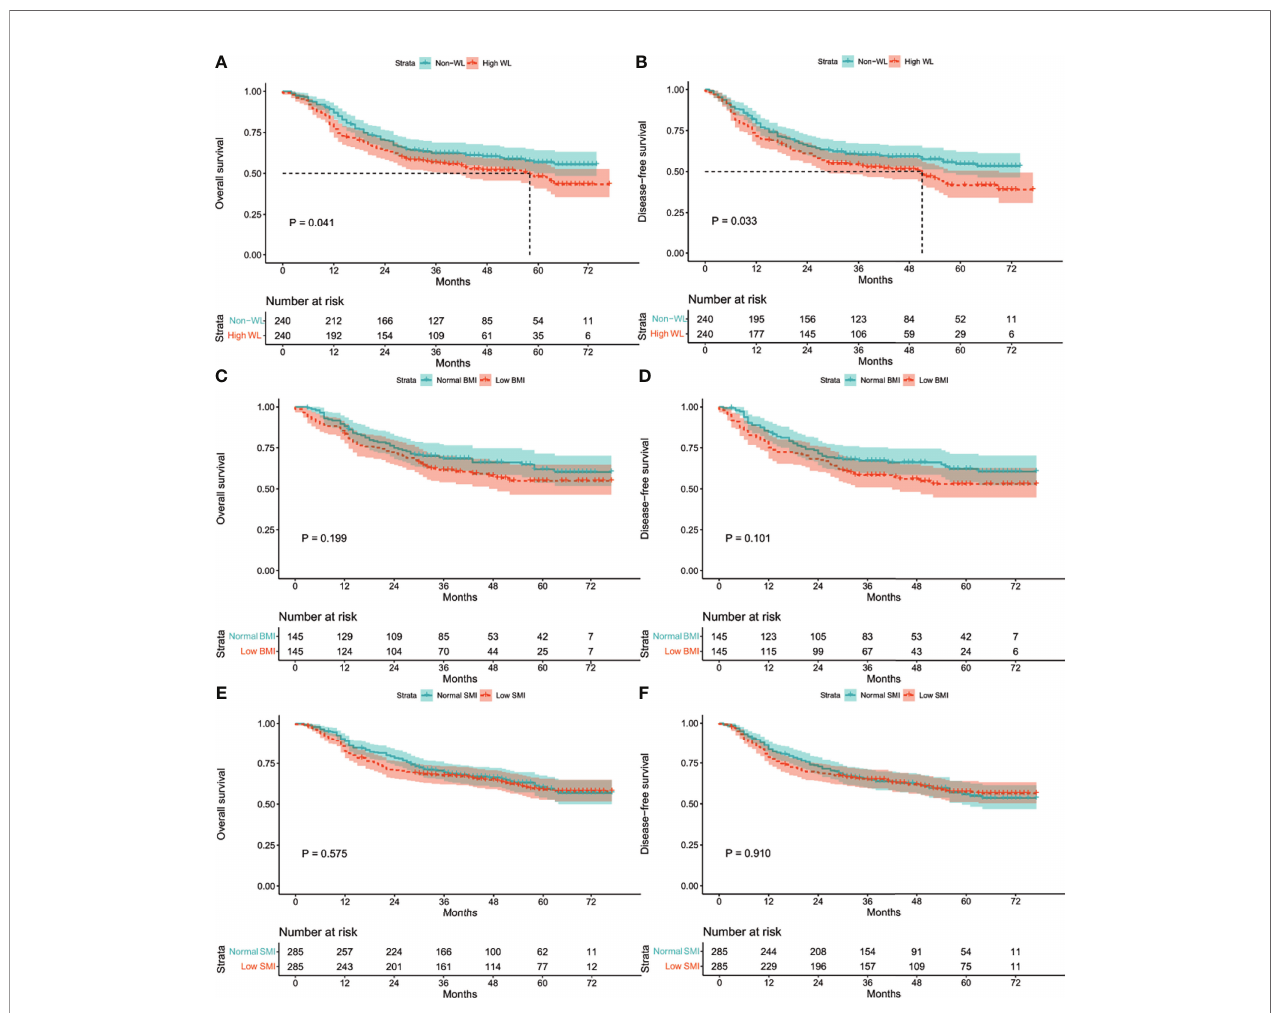
FIGURE 2 | Kaplan-Meier curves: (A) in the matched WL cohort for OS rate; (B) in the matched WL cohort for DFS rate; (C) in the matched BMI cohort for OS rate; (D) in the matched BMI cohort for DFS rate; (E) in the matched SMI cohort for OS rate; (F) in the matched SMI cohort for DFS rate. WL, weight loss; BMI, body mass index; SMI, skeletal muscle index; OS, overall survival; DFS, disease-free